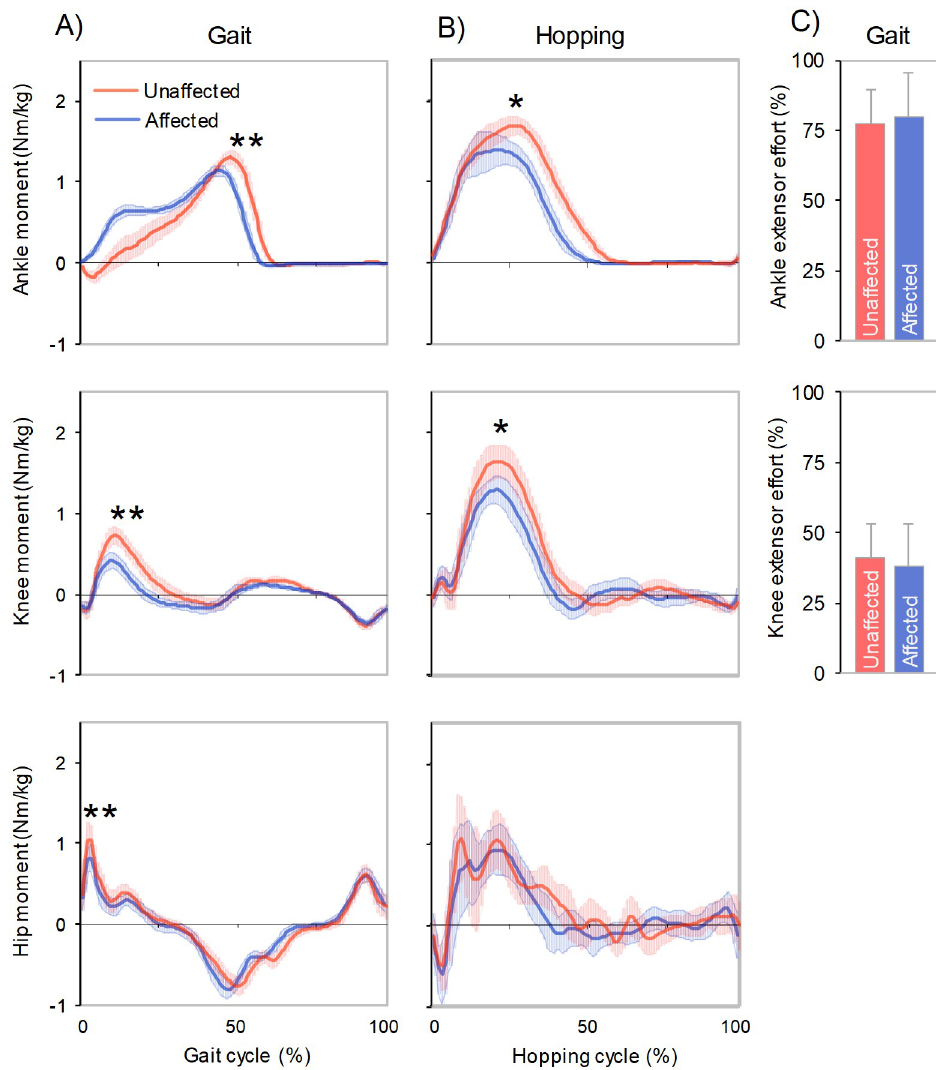
Fig 1. Lower limb joint moments across limbs during A) gait and B) two-leg hopping test. C) Relative efforts for the ankle and knee extensors during